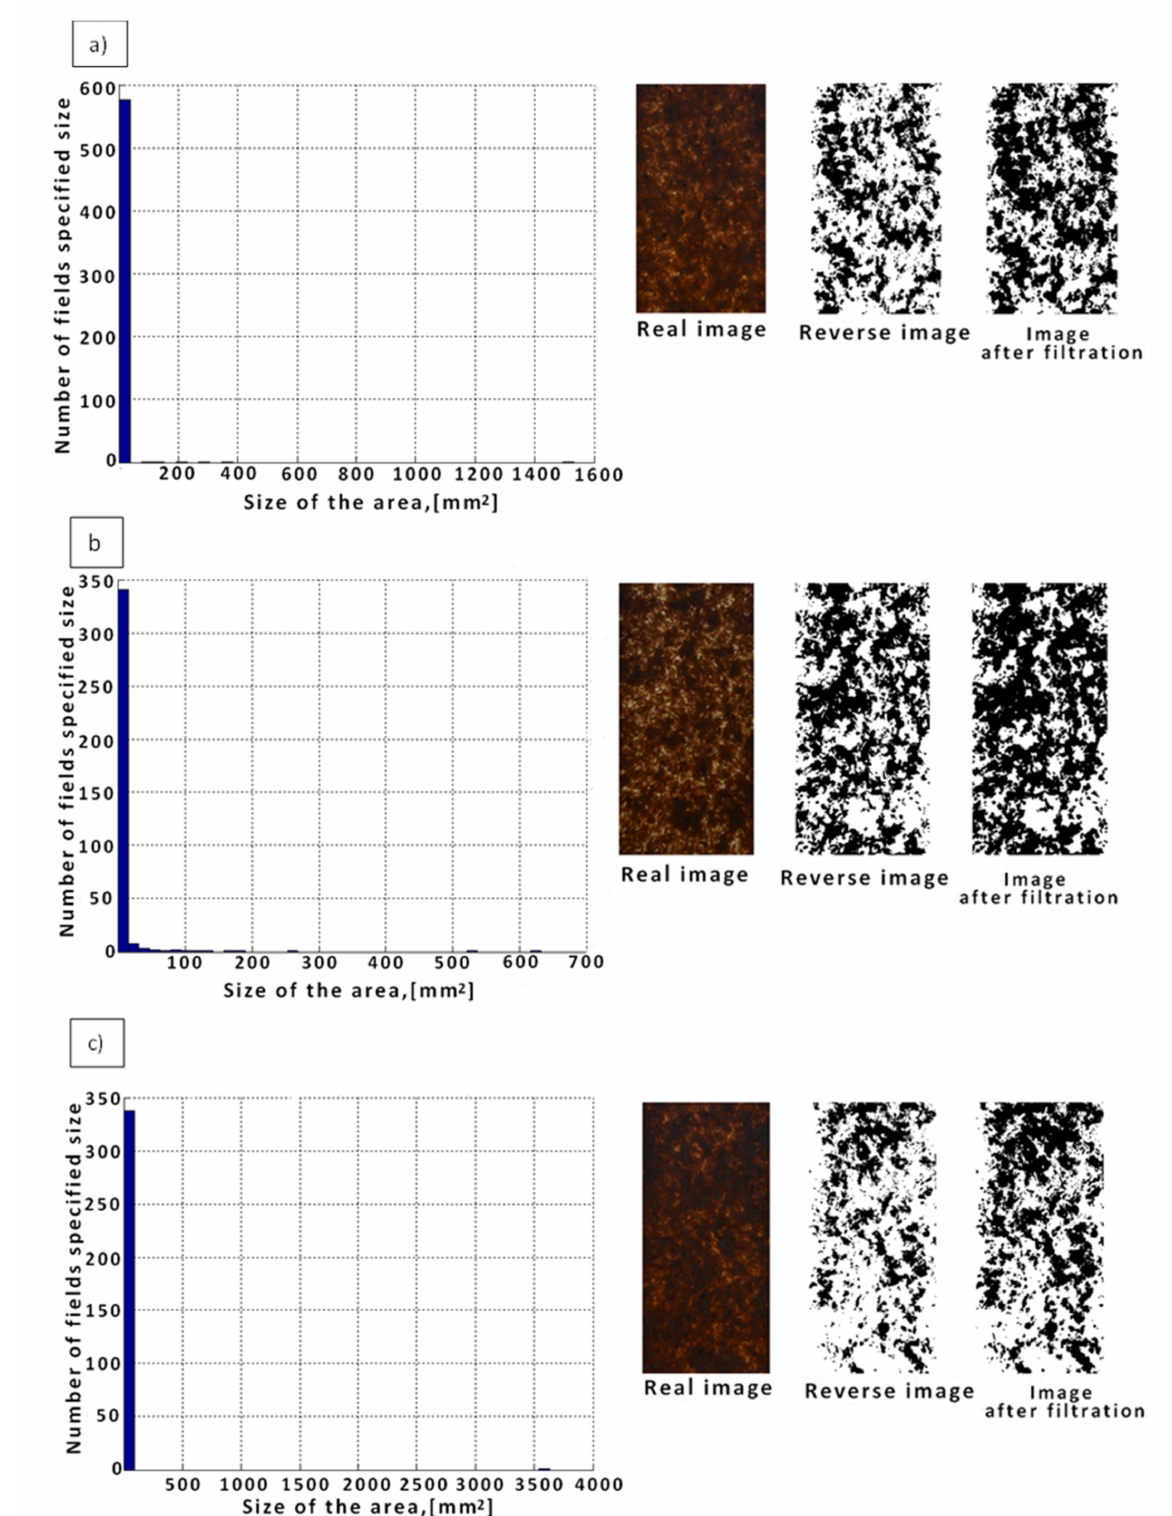
Figure 9. Histogram of the determined numbers and areas of agglomerates for WPCs with the addition of wood chips (PP/Lignocel 3-4) at constant: W S = 1.7 mm, i = 35 w t %, and at variable rotational speed: ( a ) n = 12 rpm, ( b ) n = 26 rpm, and ( c ) n = 40